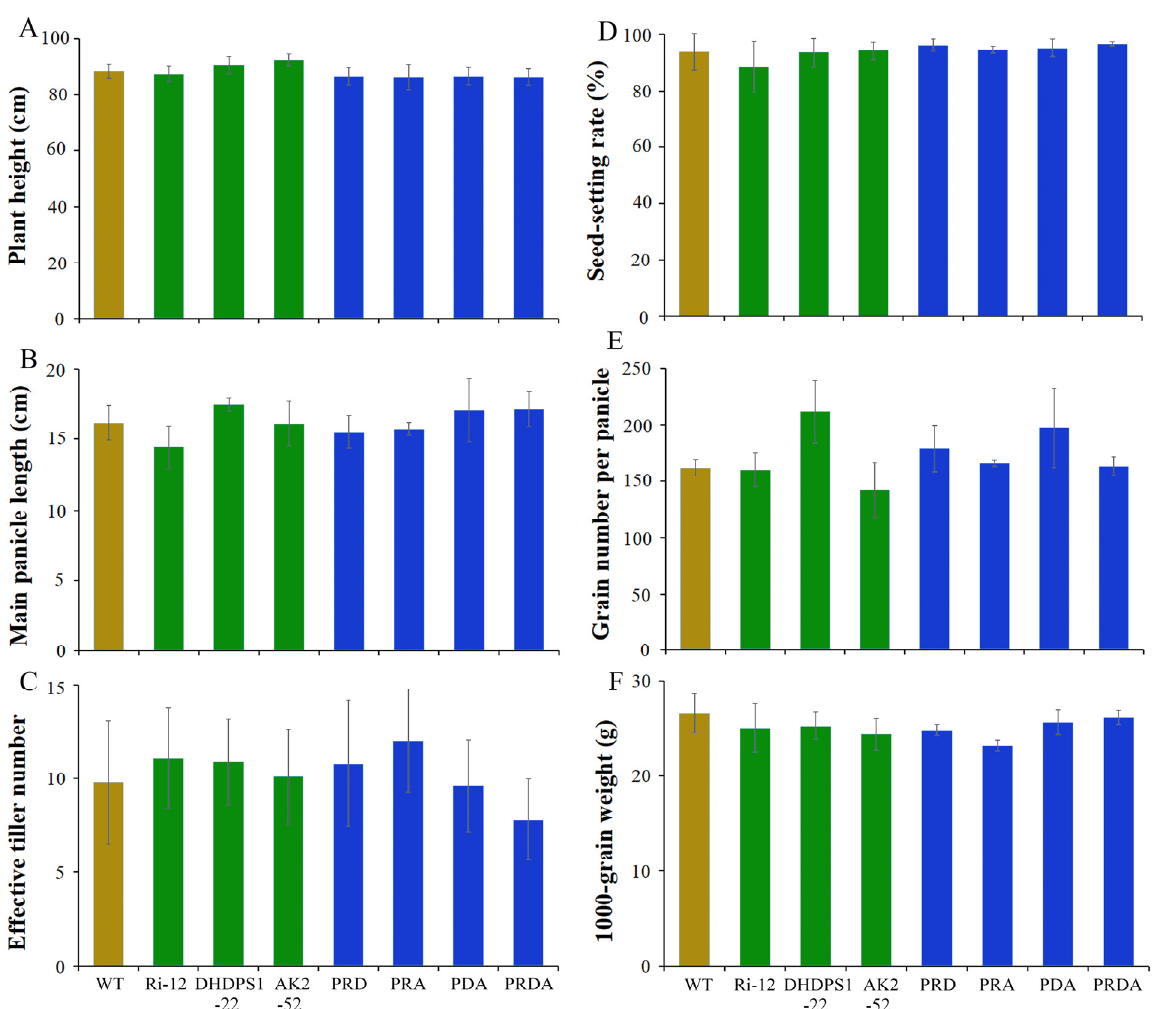
Figure 6. Investigation of the main agronomic traits of the transgenic and WT rice. ( A ) Plant height (cm). ( B ) Main panicle length (cm). ( C ) Effective tiller number. ( D ) Seed-setting rate (%). ( E ) Grain number per panicle. ( F ) 1000-grain weight (g).